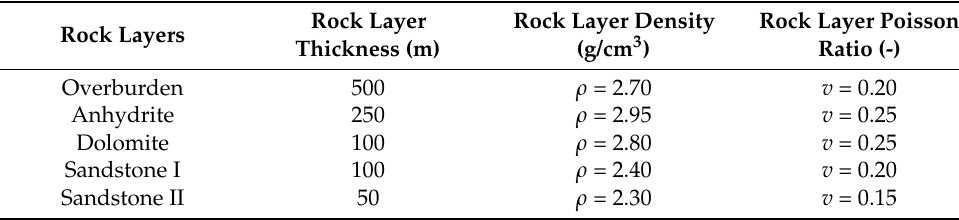
Table 2. Rock mass parameters for the excavation drilled in sandstone.